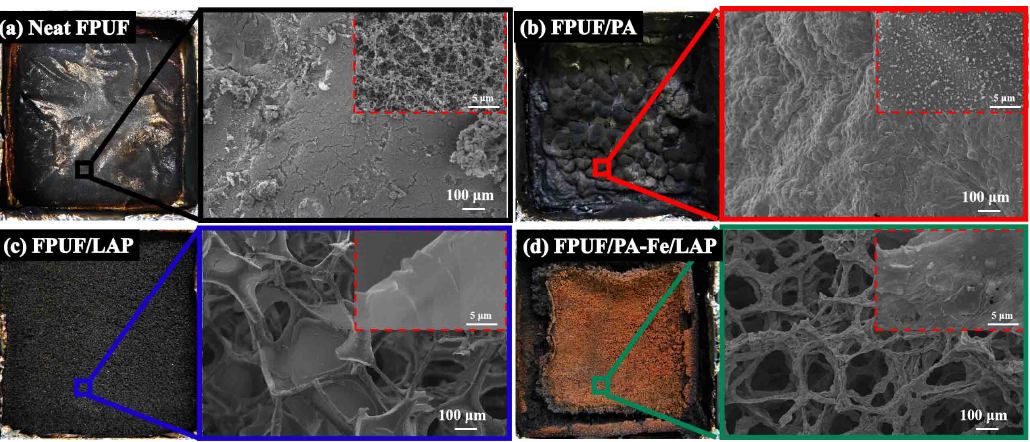
Figure 8. Morphology of the char residues of Neat FPUF ( a ), FPUF/PA ( b ), FPUF/LAP ( c ), and FPUF/PA-Fe/LAP ( d ) after CCT.